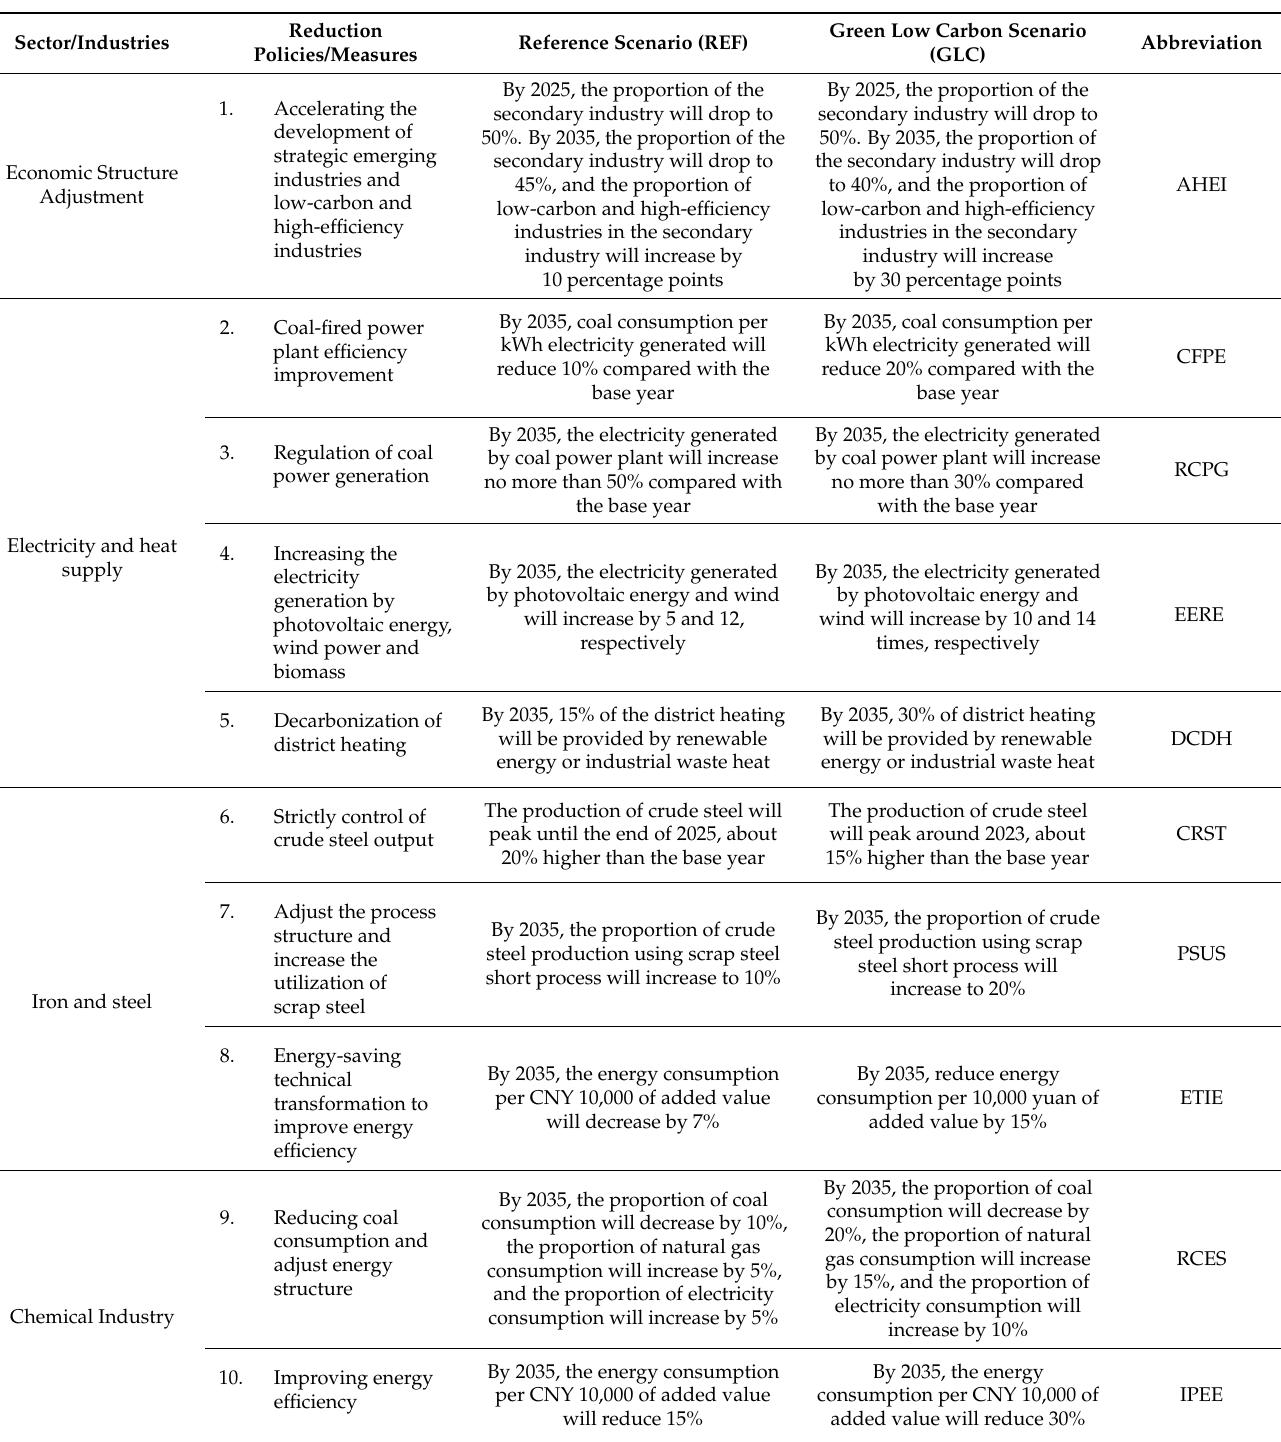
Table 2. Scenario settings based on the carbon emission peak